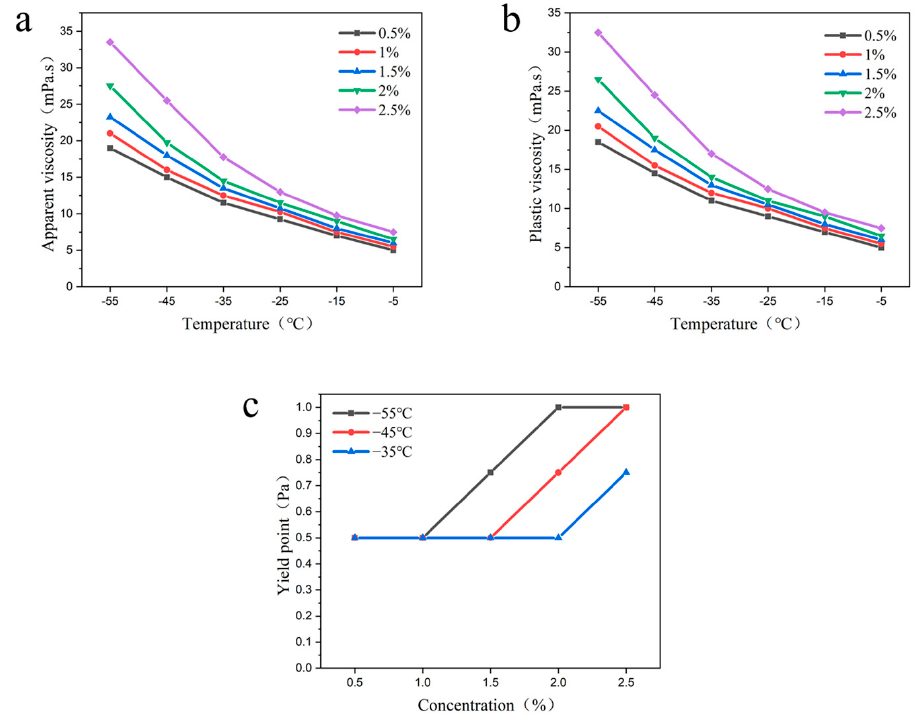
Figure 7. Effects of the different concentrations of polymethacrylate on the rheological properties of the drilling fluid; ( a ) apparent viscosity; ( b ) plastic viscosity; ( c ) yield point.